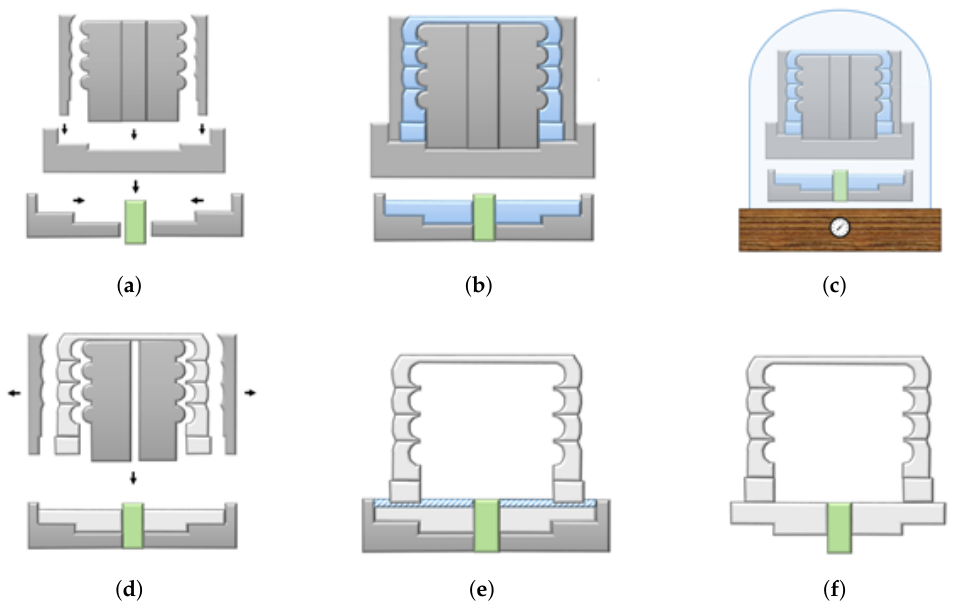
Figure 6. Molding process. The PLA mold is shown in dark gray, the fresh PDMS soft gripper is represented in blue, the precured PDMS is in striped blue, the cured PDMS soft actuator is displayed in light gray and the PUR pipe is in green. ( a ) Mold assembly. ( b ) Pouring of the PDMS on the mold. ( c ) Vacuum process. ( d ) Demolding. ( e ) Gluing with PDMS of the two resulting parts. ( f )